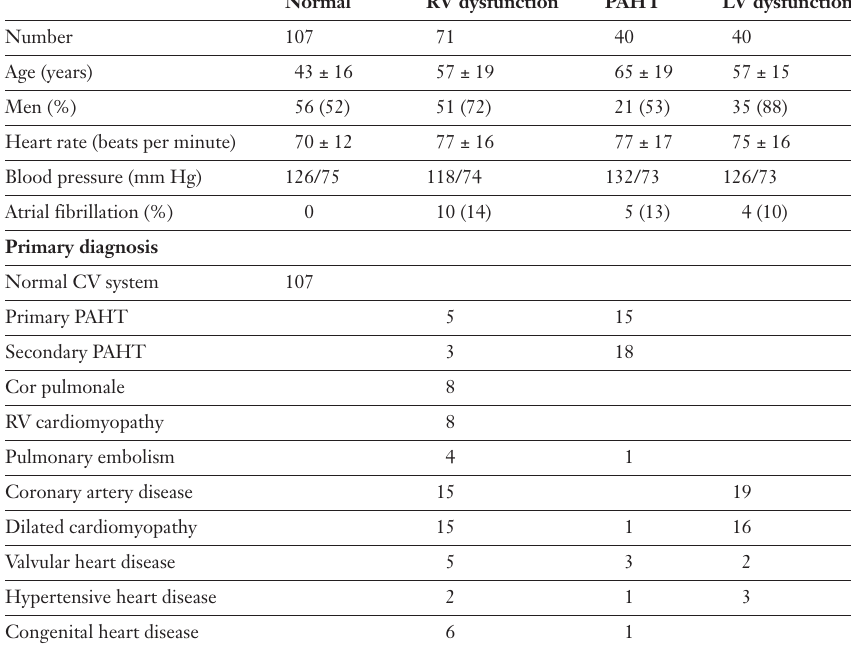
Table 1 Study subjects